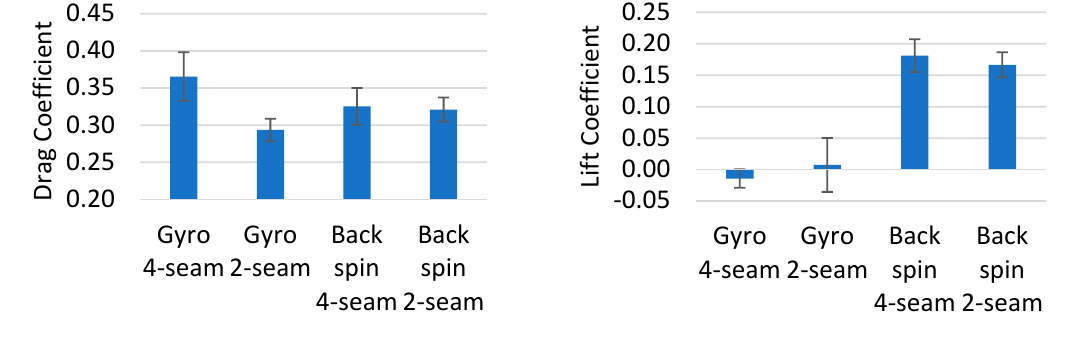
Figure 5. Average drag (left) and lift (right) coefficient of nine tested baseballs for each spin orientation. Each column indicates the average of nine